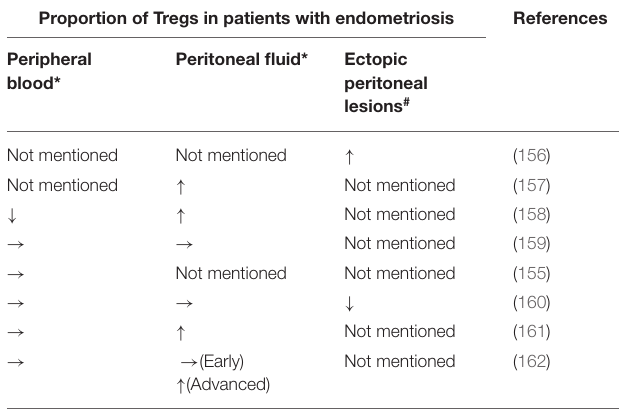
TABLE 2 | The change of the proportion of Tregs in patients with endometriosis compared with patients without endometriosis. Proportion of Tregs in patients with